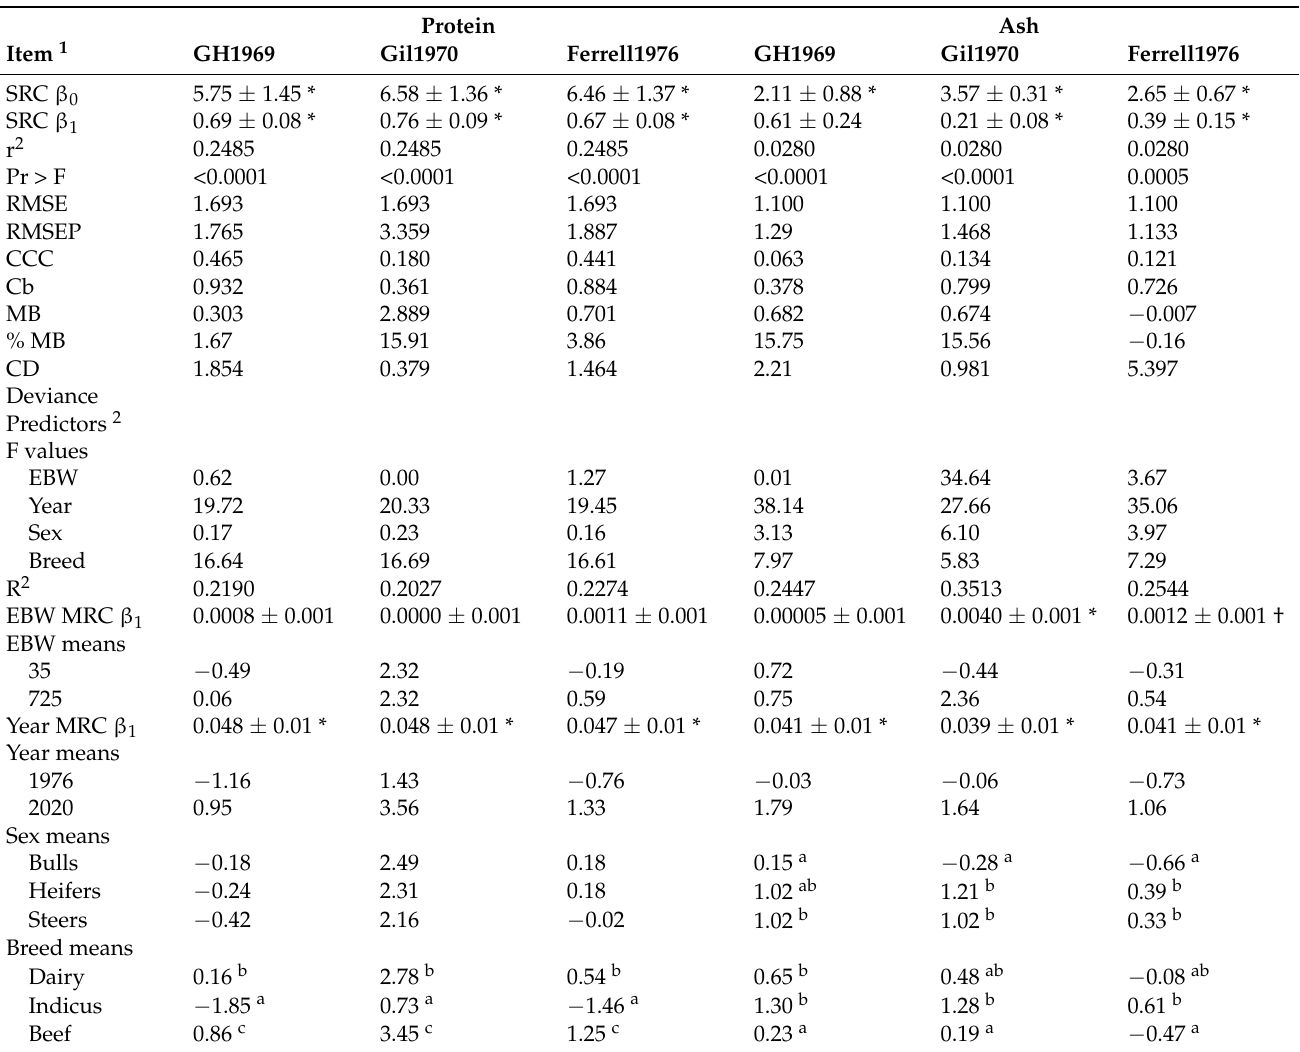
Table 6. Model evaluation of predicting empty body chemical protein and ash assuming empty body water is known, and predictive variables of the deviance between observed and predicted empty body chemical components in the Empty Body dataset.